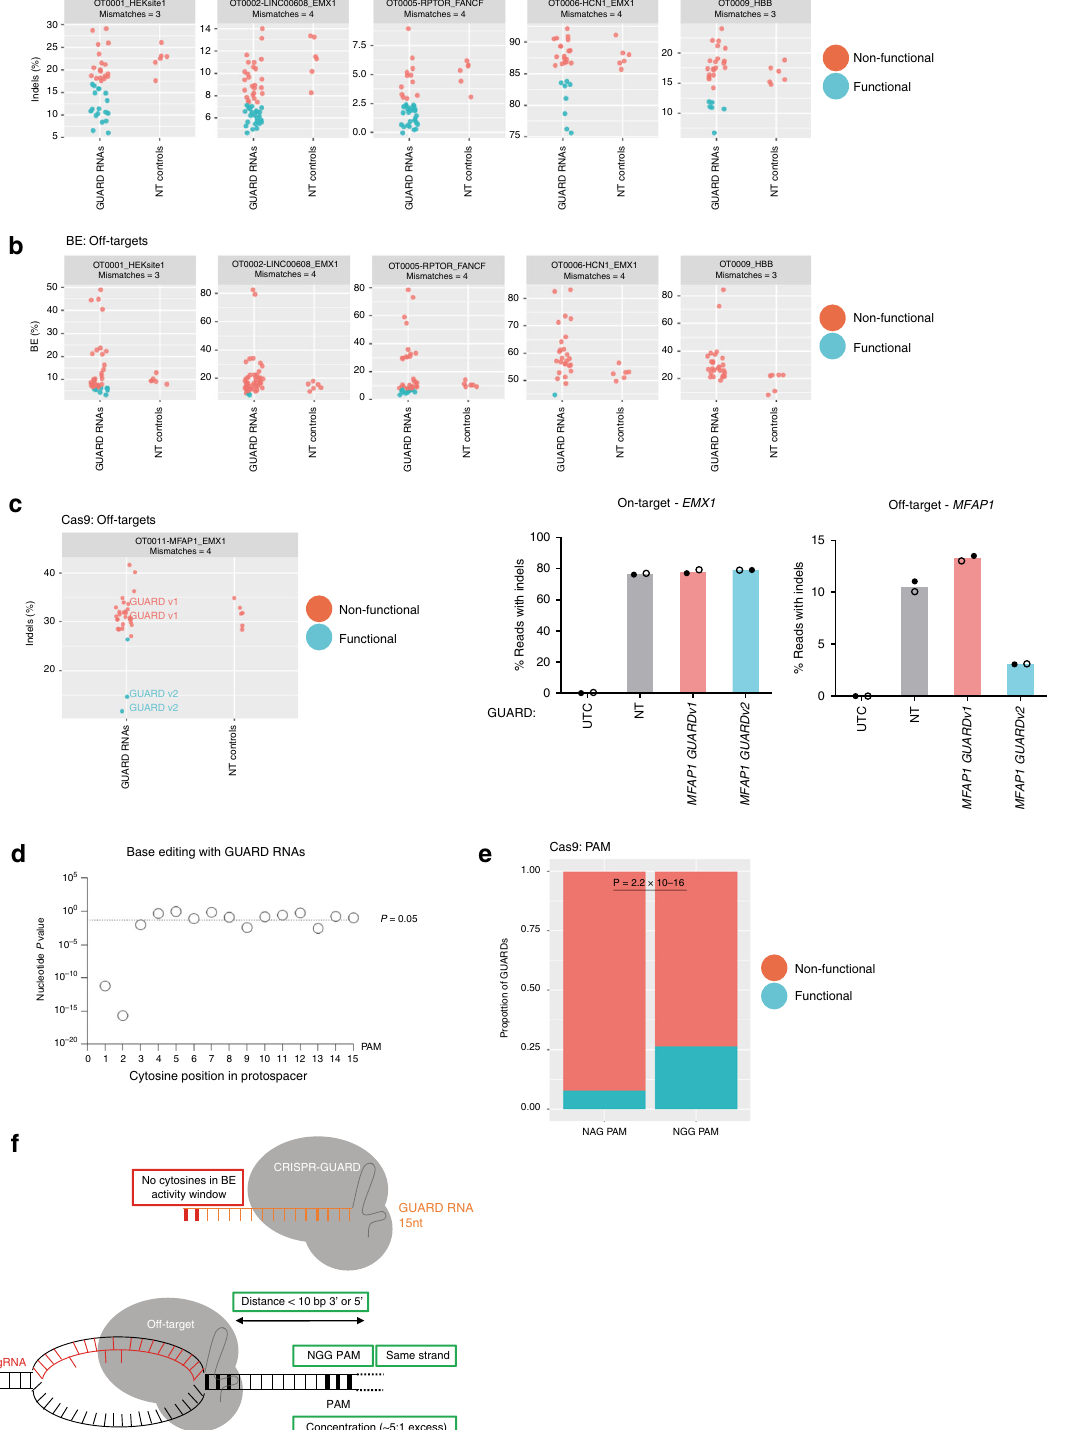
Methods CRISPR-GUARD RNAs . GUARD RNA and full-length gRNA sequences are listed in Supplementary Table 2 and are AltR modi fi ed IDT crRNAs.